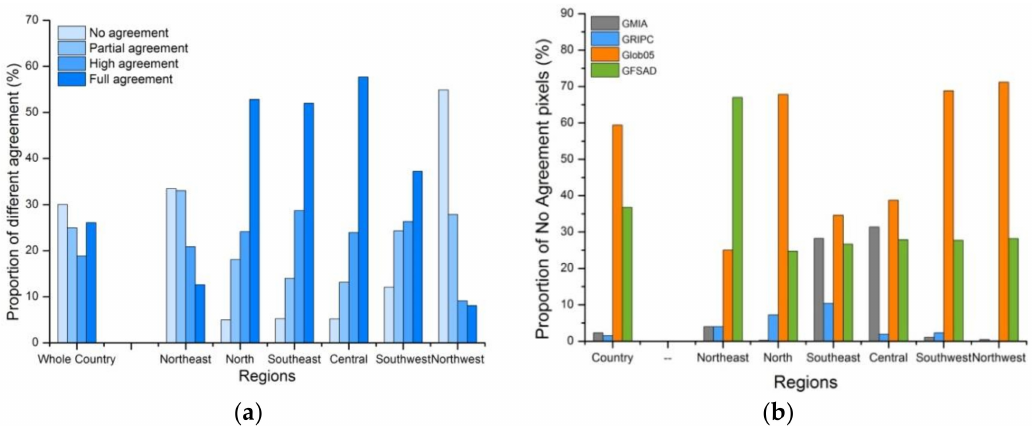
Figure 5. Summary of pixels with differing levels of agreement. ( a ) The proportions of pixels with different agreement levels in a holistic and regional view separately. ( b ) How much each dataset contributes regionally and nationally to disagreement.